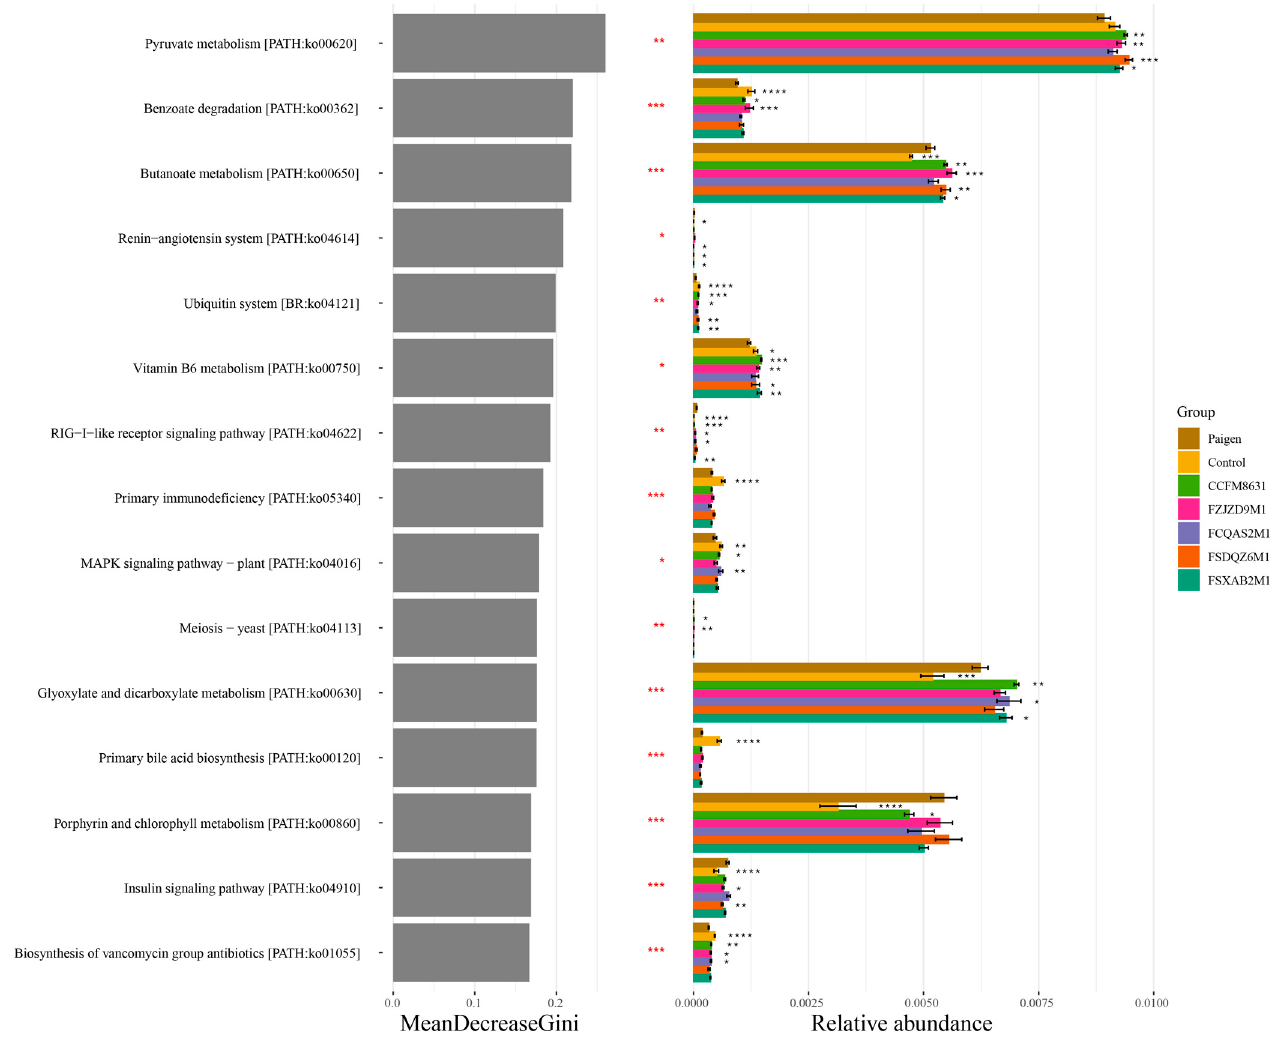
Figure 7. Lactobacillus and Bifidobacterium could regulate the potential function of the gut microbiota. Top 15 pathways/functions by microeco. n = 8. Compared with Paigen group, * p < 0.05, ** p < 0.01, *** p < 0.001, **** p < 0.0001.